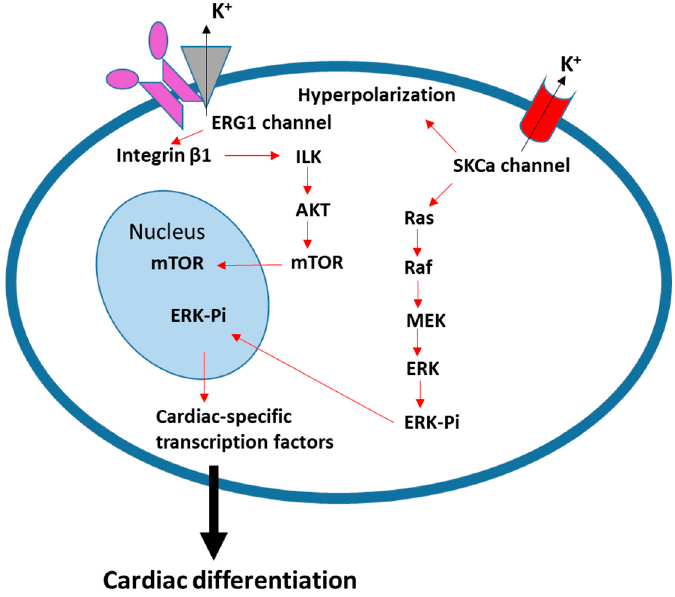
Figure 4. Membrane hyperpolarization and ion channel activation in cardiac differentiation. The activity of ERG1 and SKCa K + channels lead to membrane hyperpolarization and signaling to cardiac differentiation. See the main text for details.